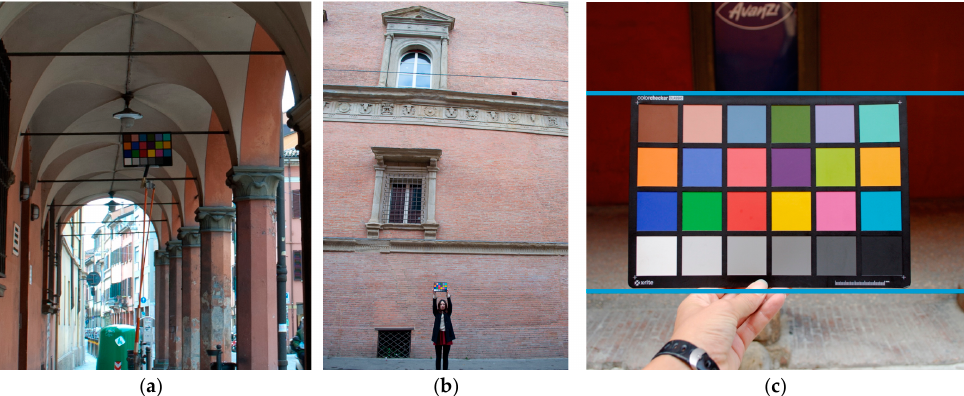
Figure 12. Some issues related to photographing the CC in order to avoid any affect to the quality of calibration: ( a ) ambient light variations causing changes in the color values and high color; ( b ) a small size of chart in the image; ( c ) a geometric deformation of shape of target (i.e., orientation and location of chart in the image, not rigid material of color chart and camera optics, etc.).